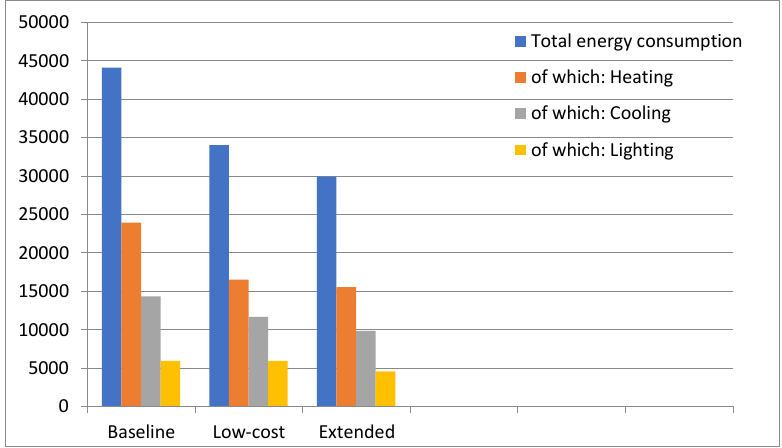
Figure 2. Annual energy consumption for heating, cooling and lighting; case of Algiers (kWh).